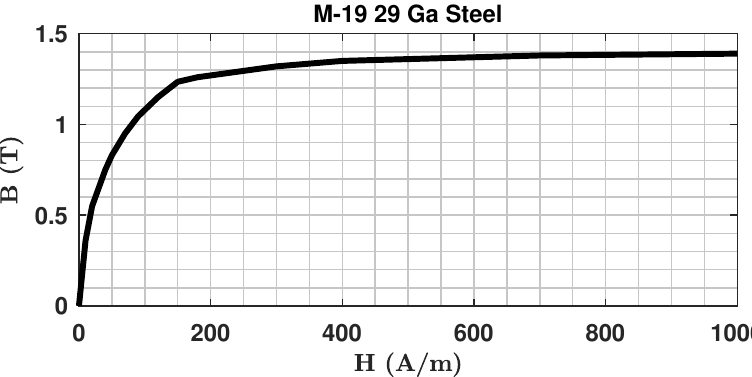
Figure 4. Magnetization curve of the used